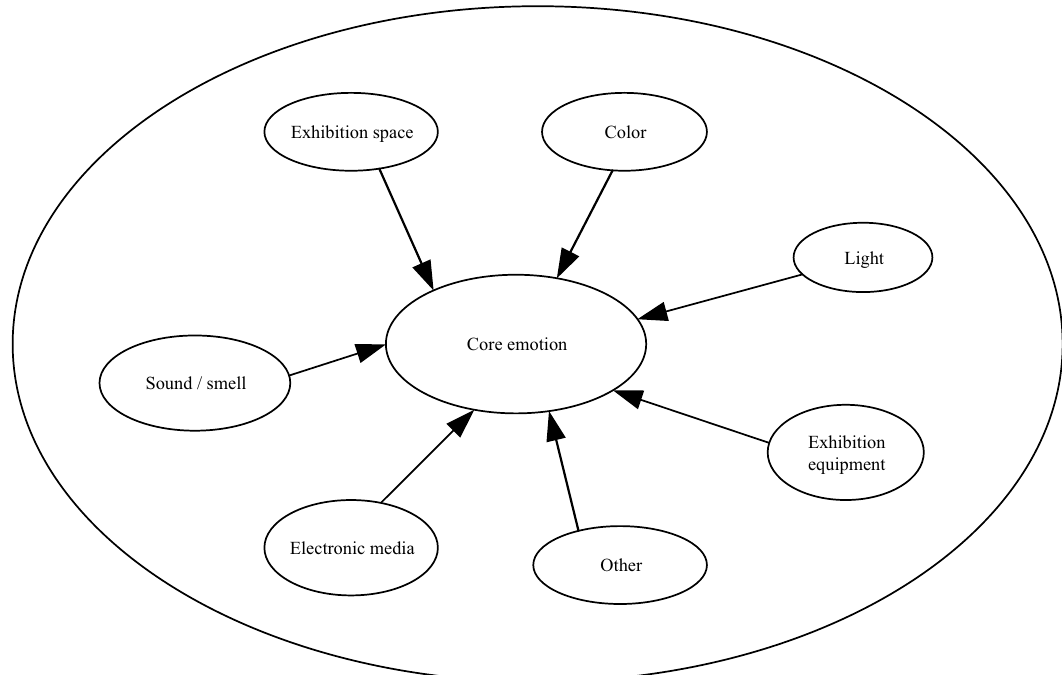
Figure 5: Color emotion expression relationship of oil painting.